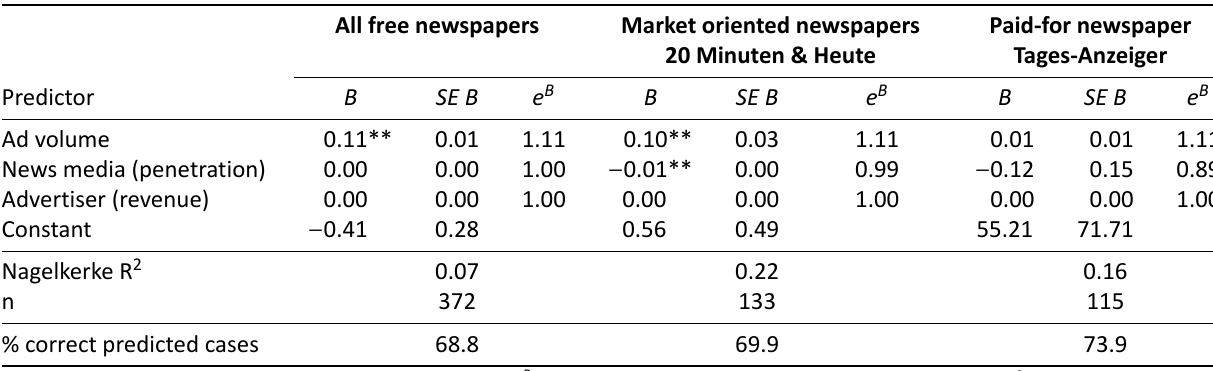
Table 3. Aggregated model for presented